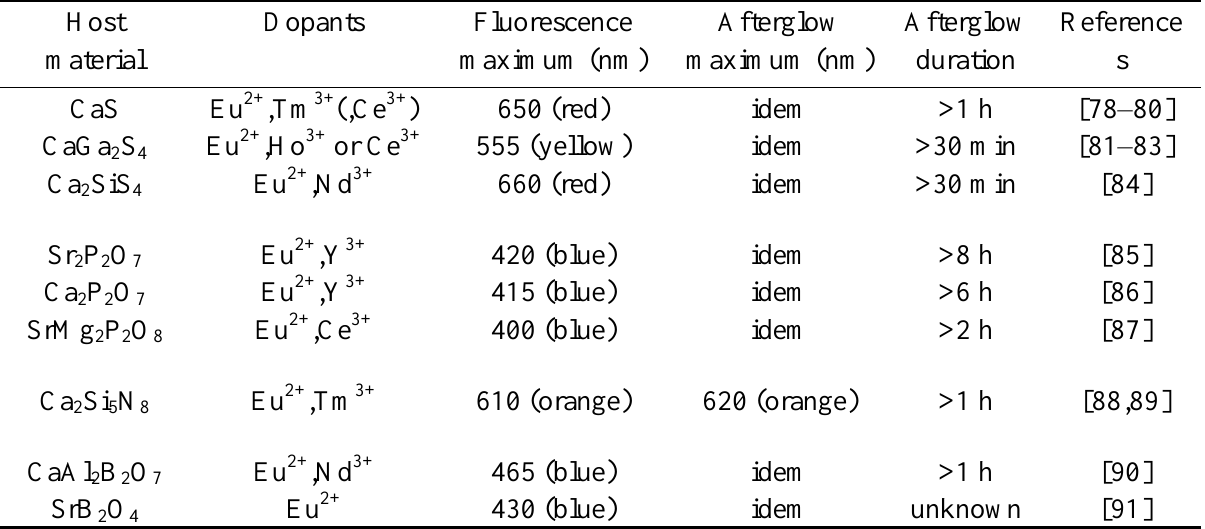
MgSi O :Eu 2+ ,R 3+ materials at 2 2 7